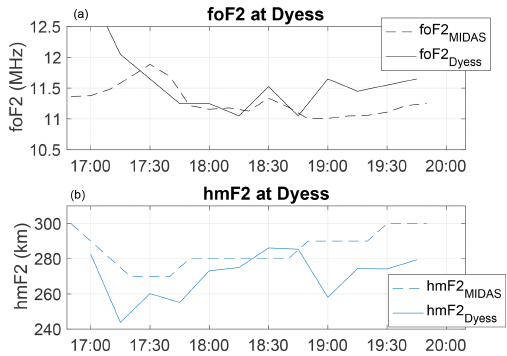
Figure 6. foF2 (a) and hmF2 (b) observations for the Dyess ionosonde (32.4 ◦ N, 99.8 ◦ W) and MIDAS equivalent sampled at the same location on 31 October 2003.